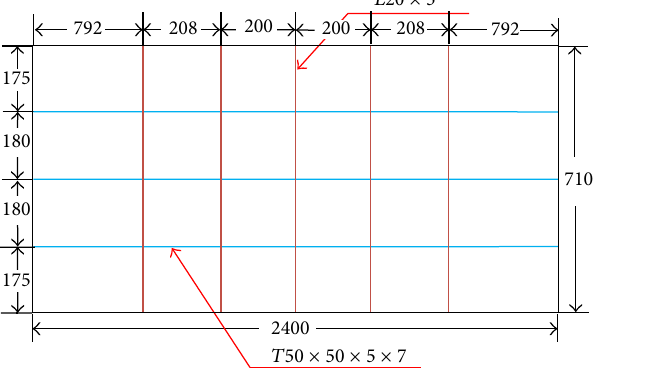
Figure 13: Geometry of the steel grillage.